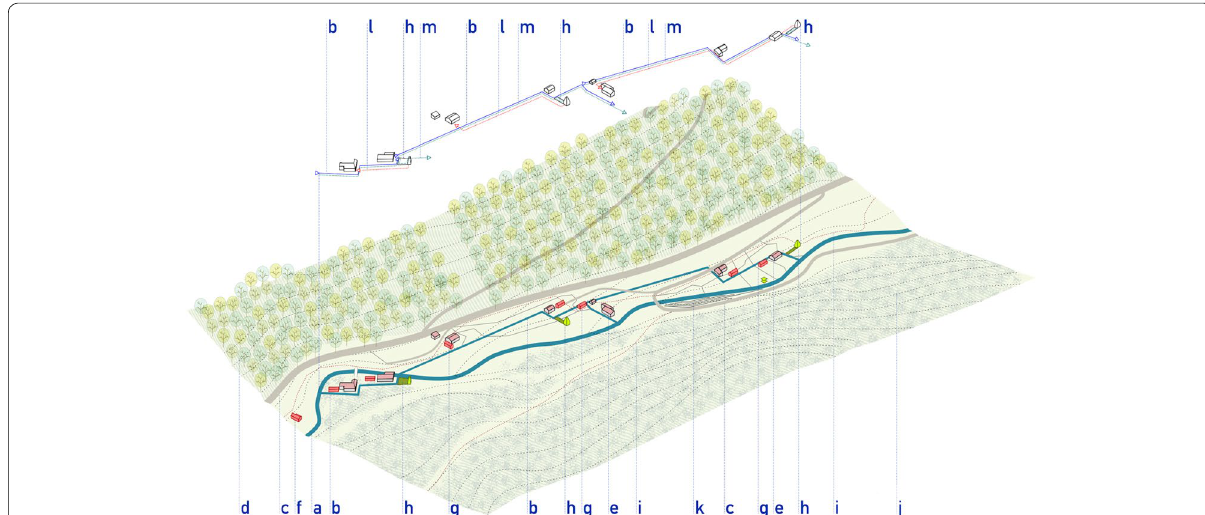
Fig. 2 Axonometric view of the center section of the valley a San Lorenzo river; b millraces; c existing roads; d existing reforestation; e existing mills, refurbished; f abandoned mill refurbished as central building of the "spread-out hotel"; g prefabricated wooden cells with FV roof (rooms for the "spead-out hotel"); h constructed wetland and biomass-boiler; i pedestrian paths; j reforestation to avoid slope erosion; k substitution of the concrete channel with staggered gabion walls; l insulated pipes for hot water distribution; m sewer pipes